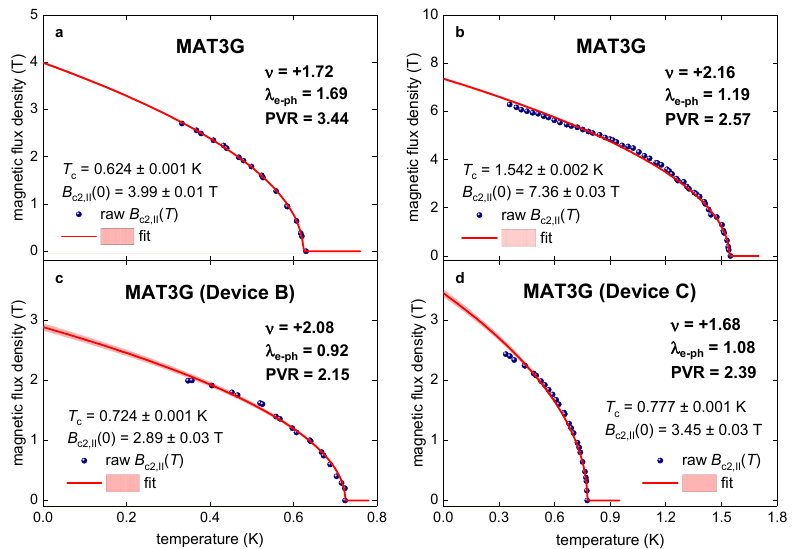
Materials 2023 , 16 , x FOR PEER REVIEW